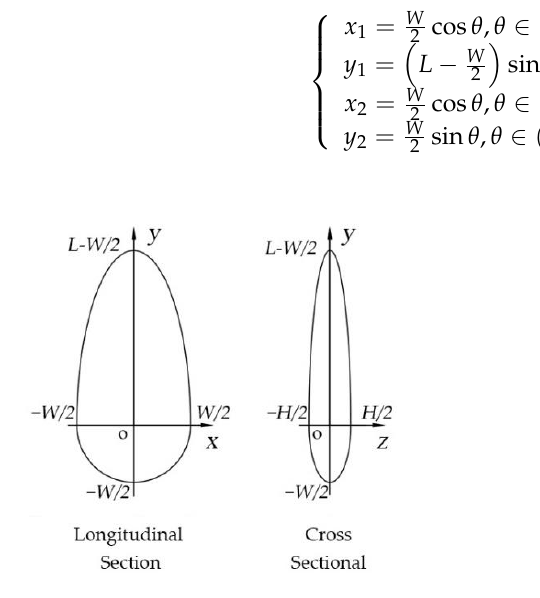
Figure 6. Fitting contour coordinates.